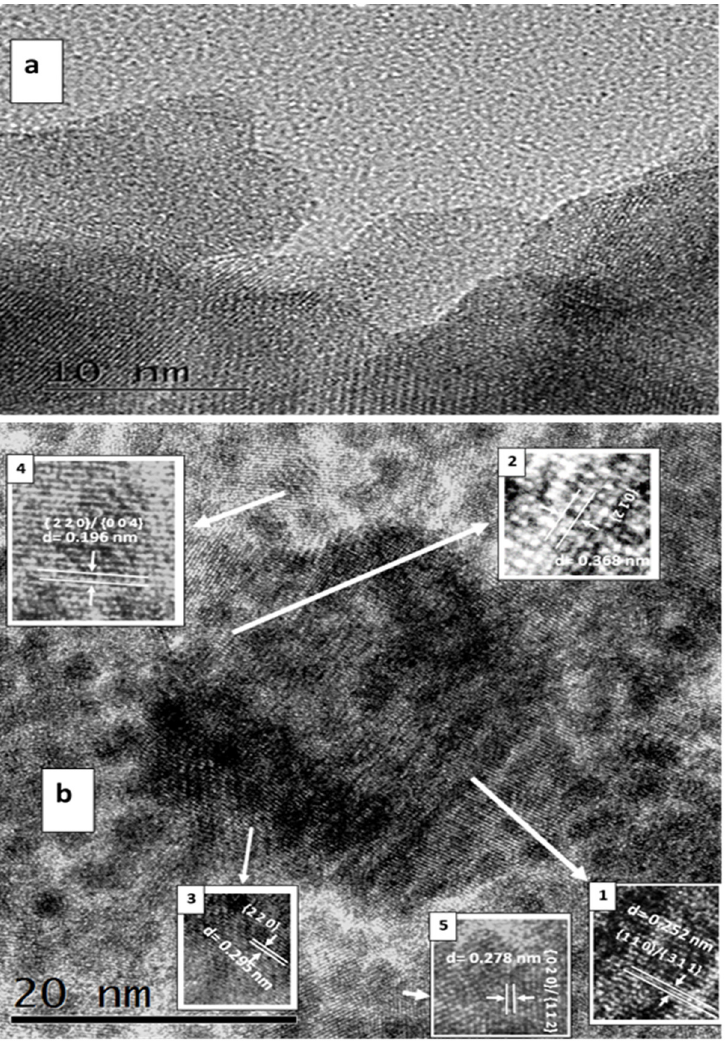
Figure 7. HRTEM images of LSF shell covering the of Fe 2 O 3 nanocrystals in CS-4 ( a ) and CS-5 ( b